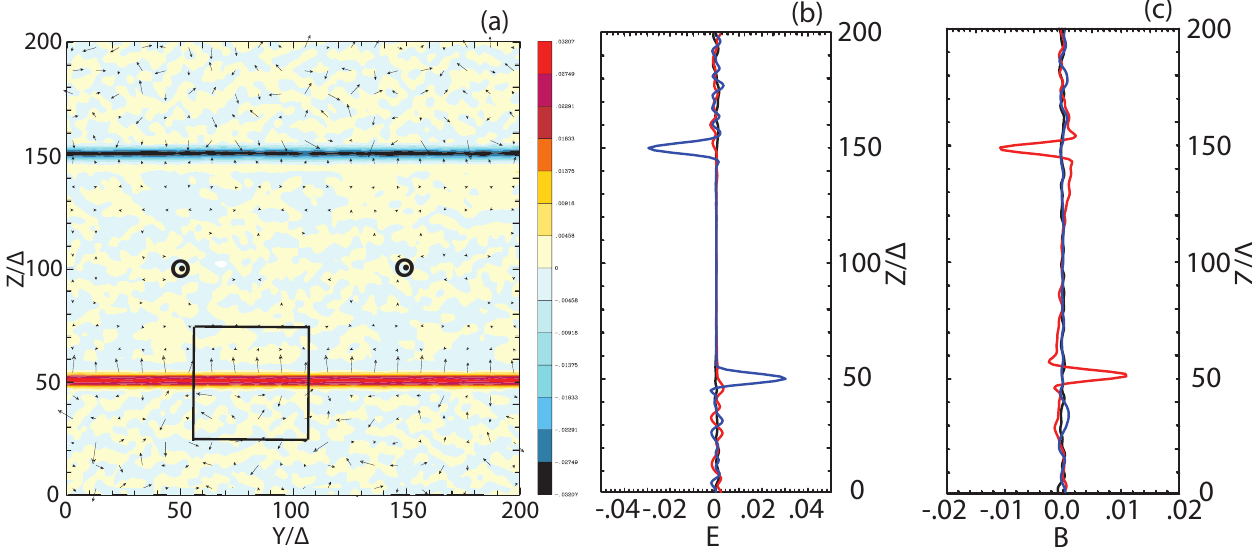
Fig. 1. Panel (a) shows our simulation model where the sheath plasma can be stationary or moving in the same direction as the jet core. In this simulation the sheath velocity is zero. Panel (b) shows the magnitude of B y plotted in the x - z plane (jet flow in the + x direction indicated by the large arrow) at the center of the simulation box, y = 100 ∆ at simulation time t = 70 ω − 1 pe for the case of γ j = 15 and m i /m e = 1836. This panel covers one fifth of the whole simulation system. The arrows show the magnetic field in the plane.